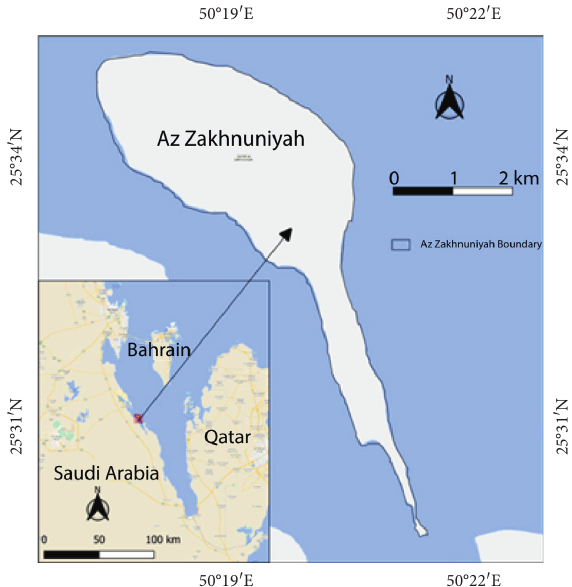
Figure 1: Study area map showing Az Zakhnuniyah island. Base map credits: google